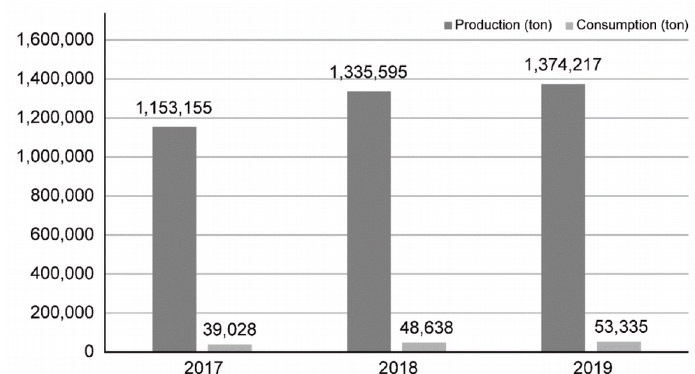
Figure 1. Production and consumption of cayenne pepper in Indonesia for